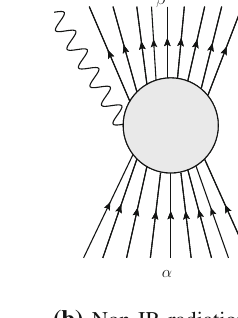
Fig. 1 Comparison of IR-radiation and non-IR radiation in the scattering process α → β . IR-radiation is the IR-divergent part of emission from external lines, i.e. from an incoming or an outgoing particle. In